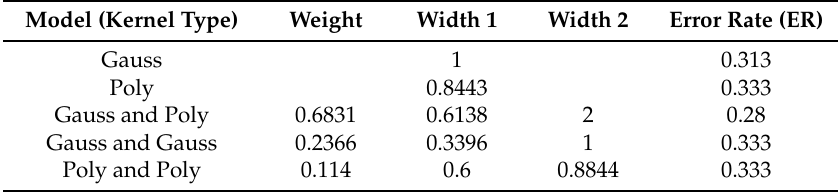
Table 2. Kernel parameters and weight coefficient optimized using the PSO algorithm. Poly,